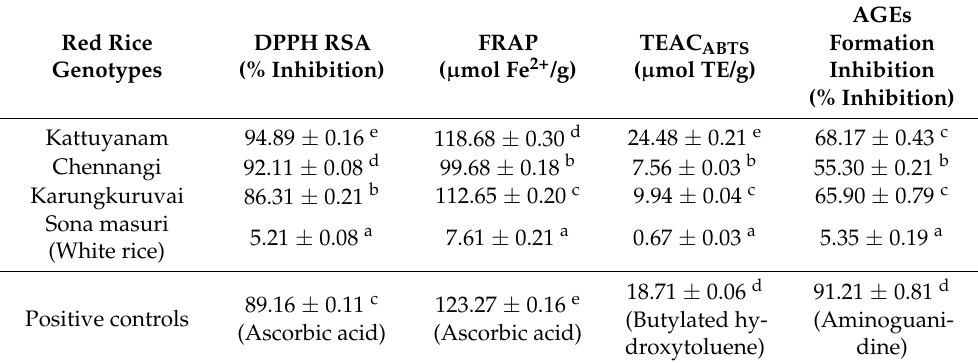
Table 2. Antioxidant activity and advanced glycation end products (AGEs) inhibitory potential of the red rice genotypes.